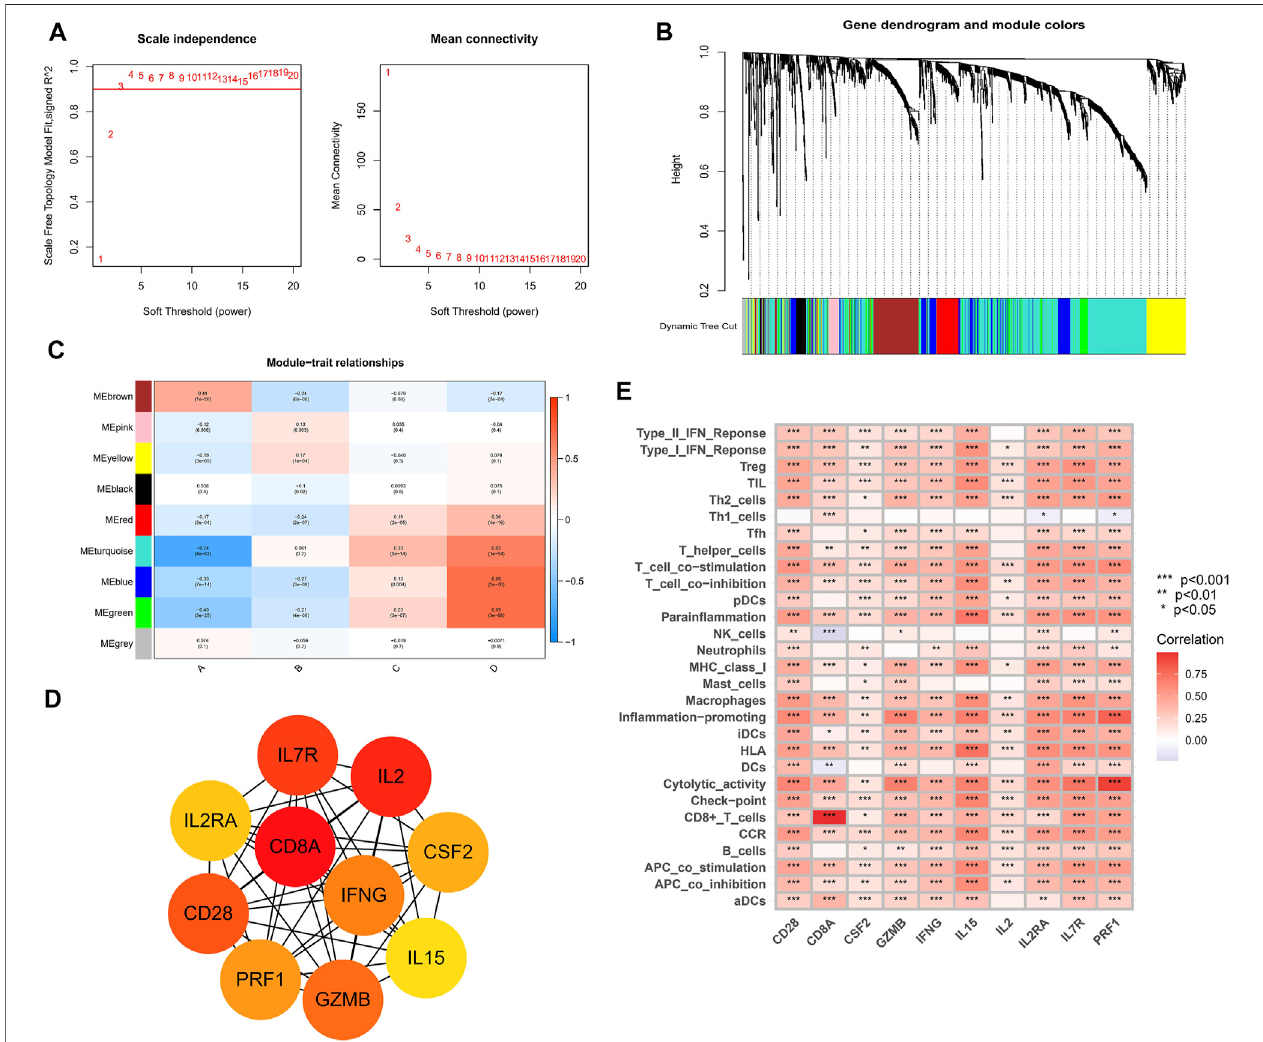
FIGURE11| Weighedco-expressionanalysisofimmuno-relatedgenesintheTCGAcohort. (A) Selectionofsoftthresholdingpower (B) Genedendrogramandthe correlation modules. (C) Heat map of module-trait relationships. (D) Hub genes and their internal correlation network. (E) Correlation heat map for hub genes and immune gene